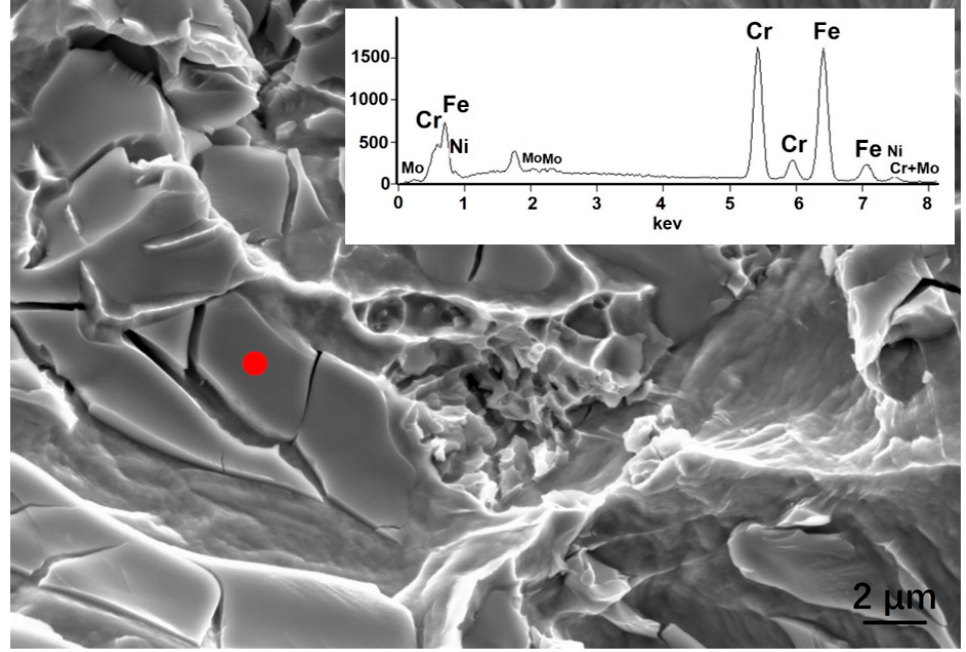
Figure 12. Fracture surface of aged Z3CN20.09M specimen and EDS results in the regions marked by red dot circle (insert).